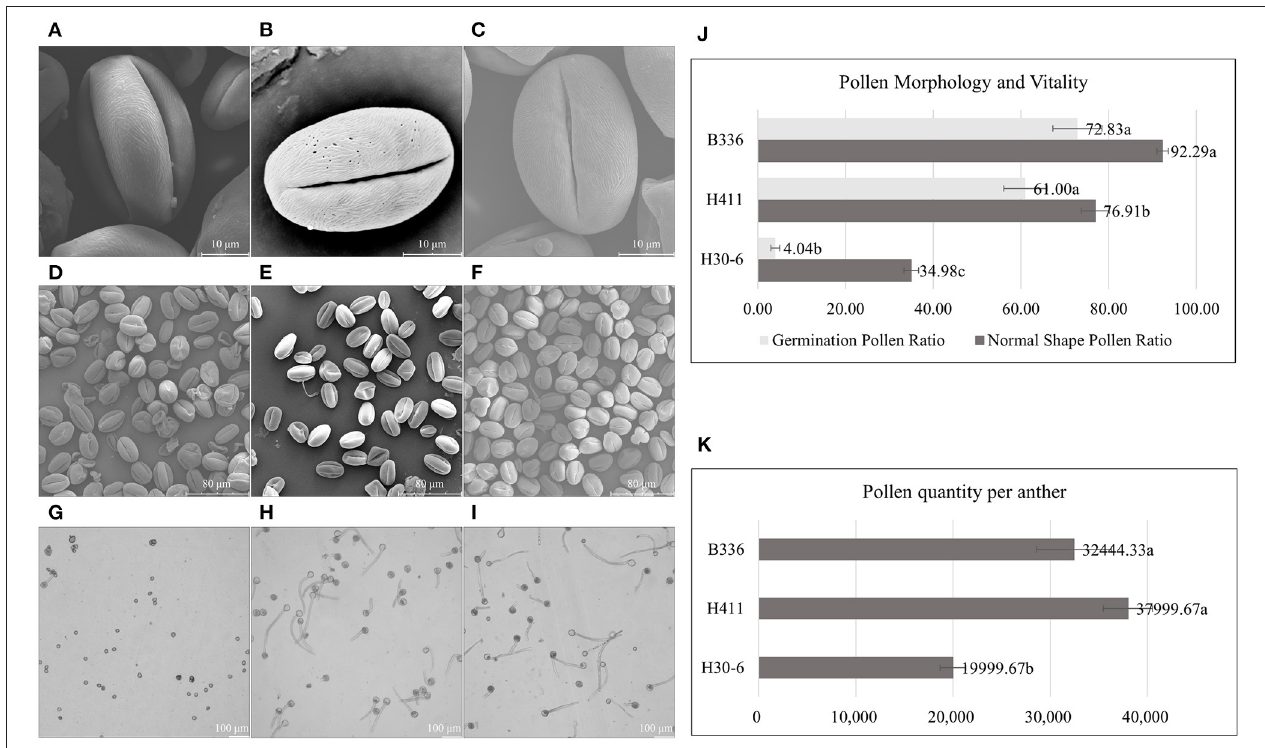
FIGURE 3 | Pollen morphology as observed via scanning electron microscopy, images of pollen germination, numbers of normally shaped pollen grains and germinated pollen grains, and pollen quantity per anther: (A–C) , equatorial views of pollen grains [H30-6 (A) , H411 (B) , B336 (C) ] showing the sexine with striate ornamentation and sparse holes between the ridges. (D–F) , pollen grains of H30-6, H411, and B336 under the scanning electron microscope. (G–I) , in vitro pollen germination of H30-6, H411, and B336, respectively. (J) normal shape pollen ratio and germination pollen ratio of H30-6, H411, and B336. (K) pollen quantity per anther. The statistical differences in means of normal shape pollen ratio, germination pollen ratio among H30-6, H411, and B336 were determined using the LSD test separately; different letters beside the bar indicate that the means are significantly different ( P < 0.05); values are presented as mean ( ±